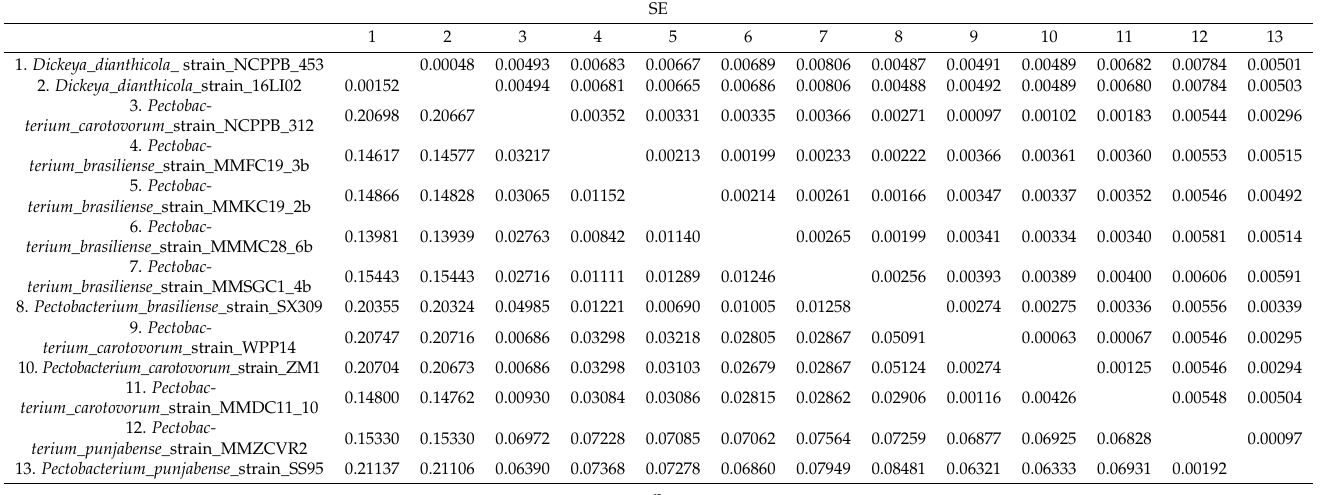
Table 4. ANI values between related members of the genus Pectobacterium according to pairwise analysis (p-distance method) based on concatenated partial sequences of genes gyrA , recA, rpoA and rpoS between selected strains. Standard errors (SE) are shown above the diagonal and were obtained by a bootstrap procedure (1000 replicates).